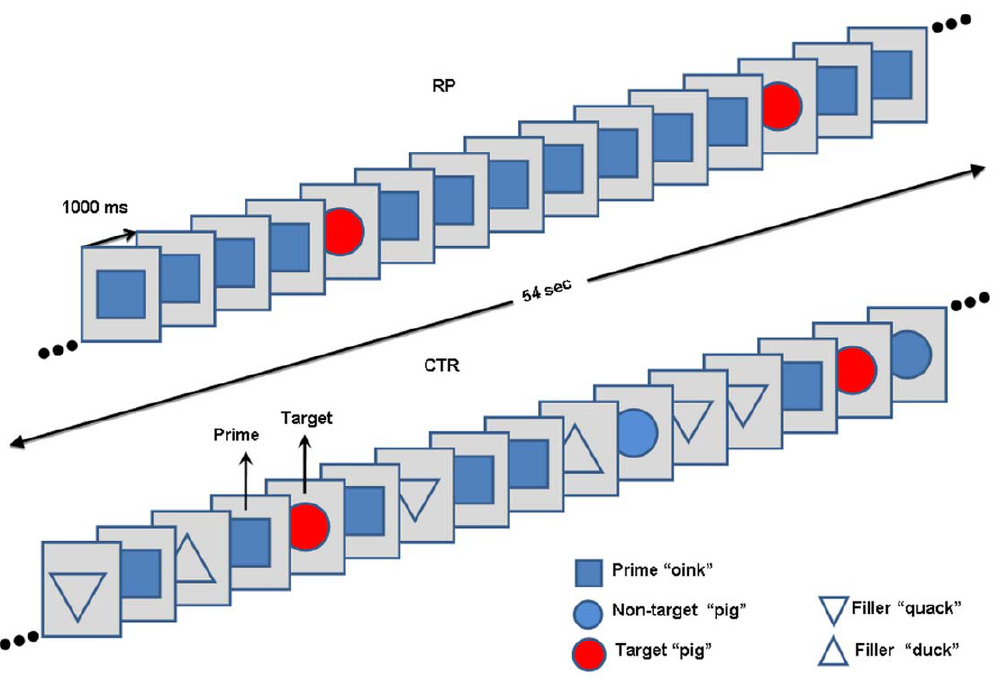
Figure 1. Experimental design: schematic diagram of sequences used in RP (upper panel) and CTR (lower panel). The example here pertains to the case when ‘‘pig’’ served as the target (onomatopoeia ‘‘oink’’ primes pig: OP), but an identical scheme of stimulation (not shown) was used when ‘‘oink’’ served as the target and ‘‘pig’’ (PO) as either the repetitive prime (RP) or the single prime preceding the target (CTR). The stimuli ‘‘duck’’ and ‘‘quack’’ served as ‘‘filler’’ stimuli and were used to prevent immediate proximity between ‘‘oink’’ and ‘‘pig’’ within the varying segments in CTR so that the target would have the same probability of occurrence as in RP ( , 17%). A complete run was divided into eight 54 msec segments separated by a 2 sec interval, each containing 54 stimuli (targets, primes and in CTR also fillers) with an SOA of 1 sec. Stimulus duration was 330 msec. For each condition (RP, CTR) there were two different sequences, one for each target-type. The four sequences were first ordered according to a Latin-square design to minimize carry-over effects and then mirror-imaged for the second part of the run. Each run started and ended with a period of 30 sec duration of white noise that served as the baseline. Note that the study used auditory stimuli (not visual), i.e., naturally produced speech stimuli (the words: ‘‘oink’’, ‘‘pig’’, ‘‘duck’’ and ‘‘quack’’) and that there were three exemplars of each word.